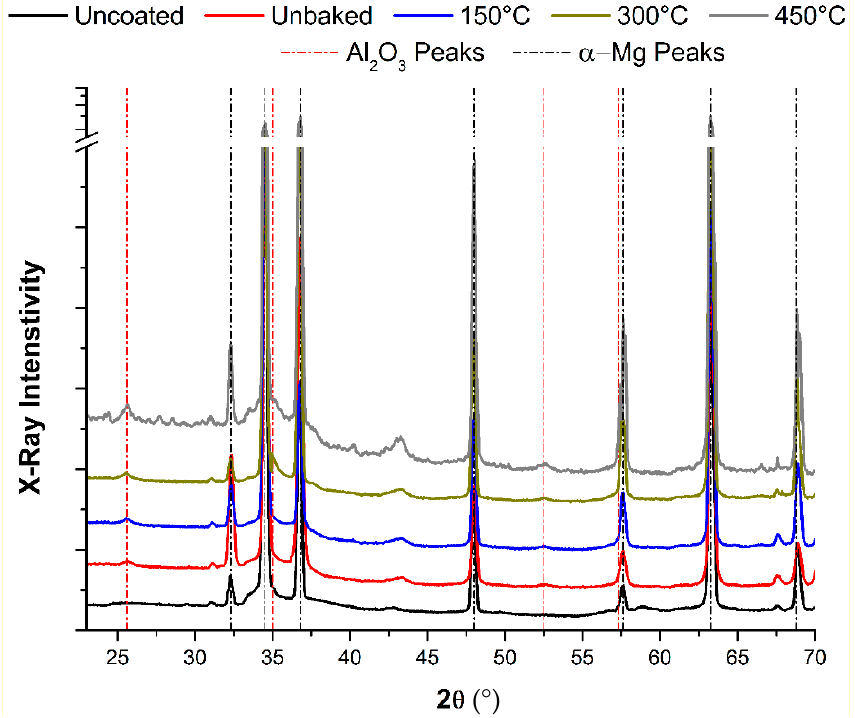
Figure 14. XRD analysis of the magnesium samples after the heating treatment.